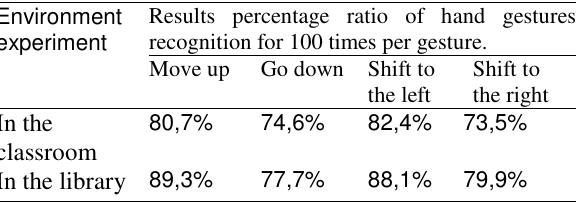
Table 1. The average percentage of four gesture